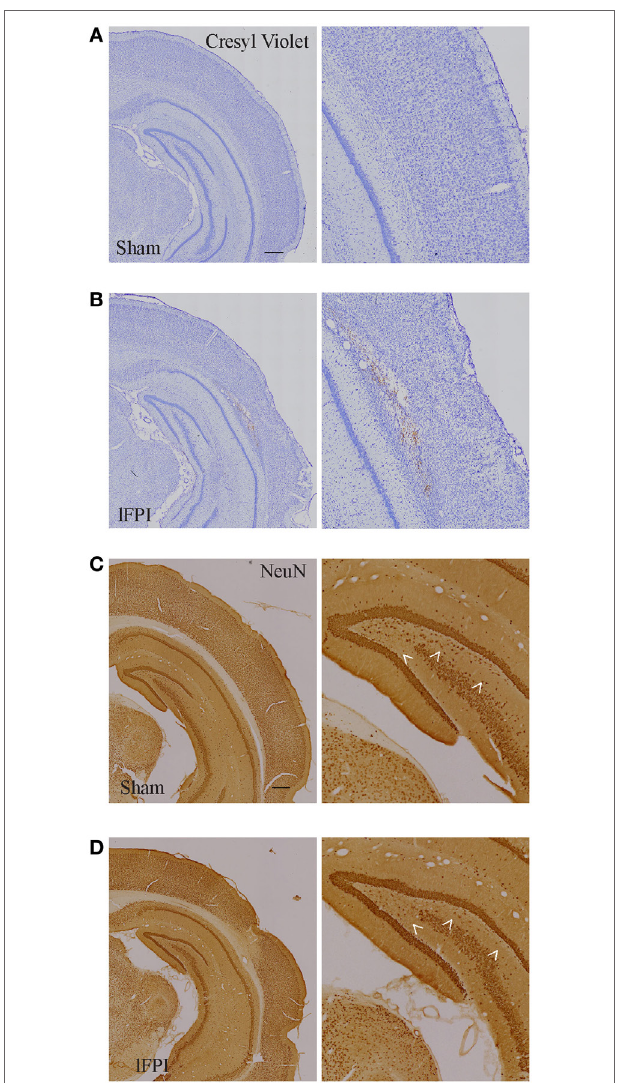
FigUre 2 | Lateral fluid percussion injury (lFPI) results in cortical damage and hippocampal neuron loss. (a,B) Representative images of cresyl violet stained and (c,D) NeuN-immunohistochemical stained coronal brain sections after sham and lFPI. lFPI produced a lesion in the cortex at the gray and white matter interface and an appearance of hilar neuron loss (arrowheads) at 3 weeks post-injury (scale bar = 500 µm, n = 6 sham and n = 6